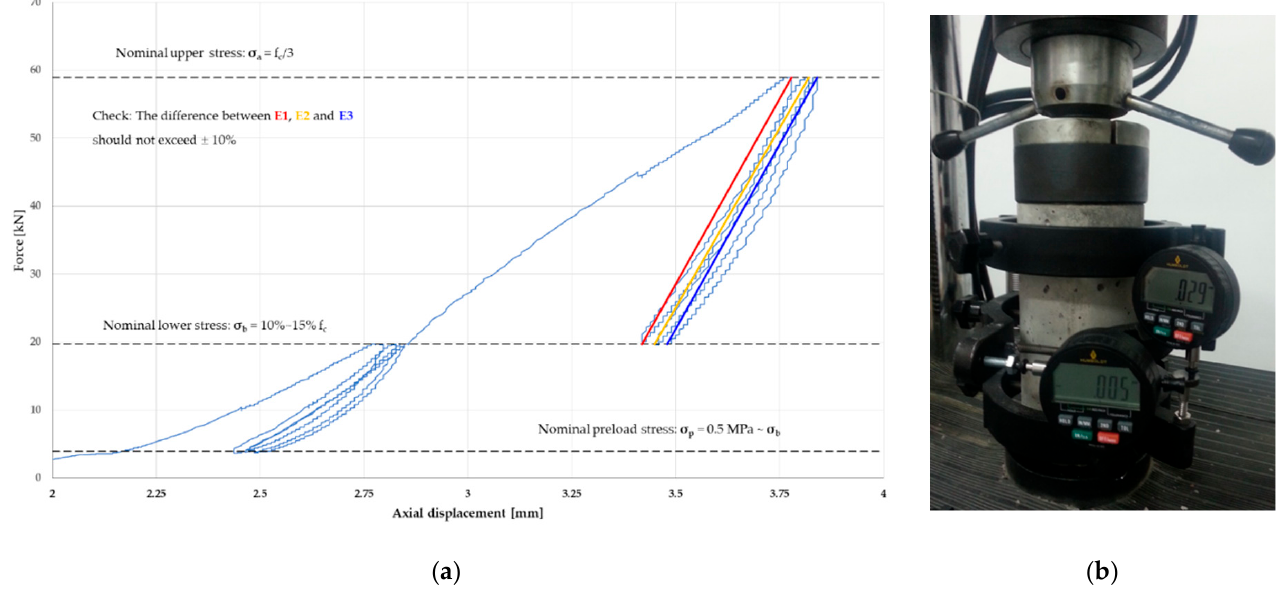
Figure 3. Assessment of the static modulus of elasticity. ( a ) Standard loading scenario; ( b ) Experimental setup.